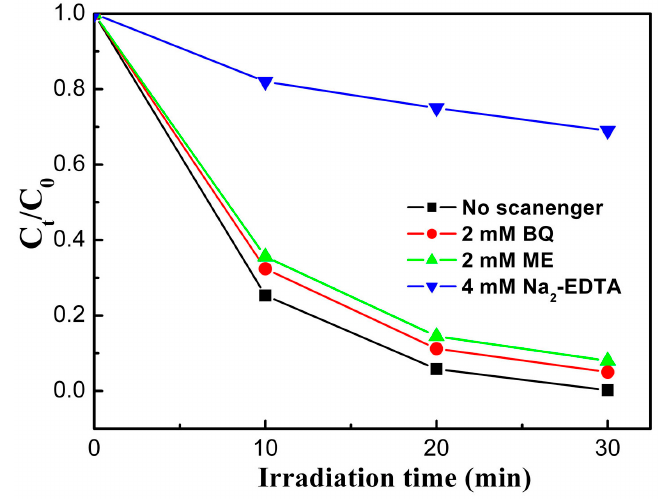
Figure 10. Effect of various scavengers on the visible light photocatalytic performance of N 0.45 B 0.55 sample toward the degradation of MB.